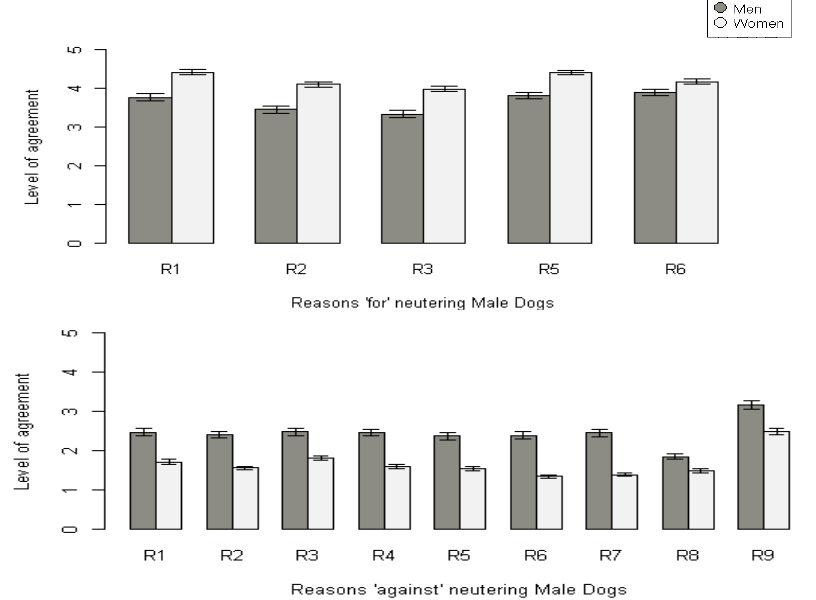
Figure 1. Mean agreement scores ( ± SE) for each statement ‘for’ and ‘against’ neutering male dogs by participant gender (men n = 161; women n = 290). ‘for’ reasons are coded as follows; R1 = To prevent unwanted puppies/kittens, R2 = To prevent unwanted behaviours, R3 = To prevent sexual frustration, R5 = To prevent reproductive diseases, R6 = To prevent unwanted genetic traits. ‘against’ reasons are coded as follows; R1 = Not necessary, R2 = The pain from the surgery, R3 = The risks of the surgery, R4 = Post-surgery inactivity, obesity or urinary incontinence, R5 = The right to body integrity, R6 = The right to reproduce, R7 = The right to have natural sexual and parental experiences, R8 = The cost, R9 = Neutering should be done only for medical reasons.